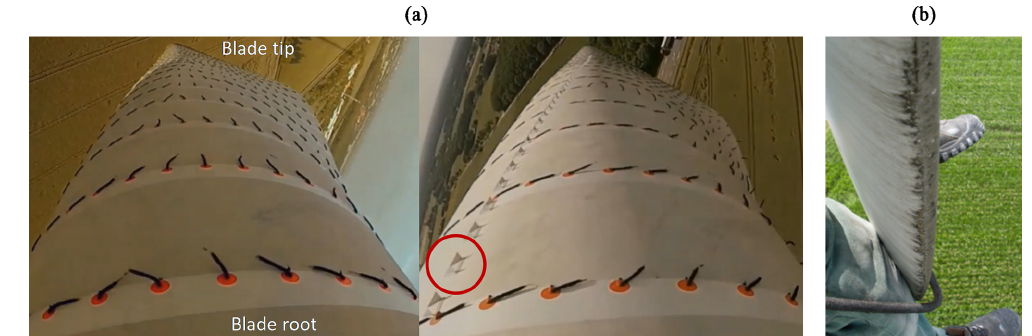
Figure 2. Utility scale wind turbines. (a) Simultaneous flow tuft measurements (baseline versus VG configuration) on the same rotor (with permission from SMART BLADE GmbH). (b) Leading-edge erosion at the blade tip (with permission from Seilpartner GmbH).